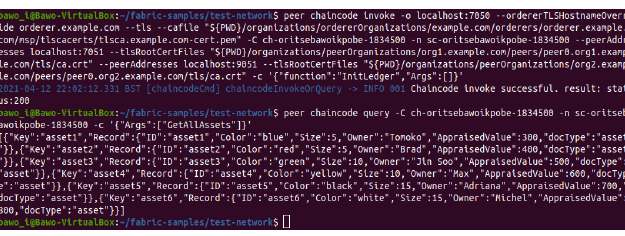
Figure 9: Asset creation.